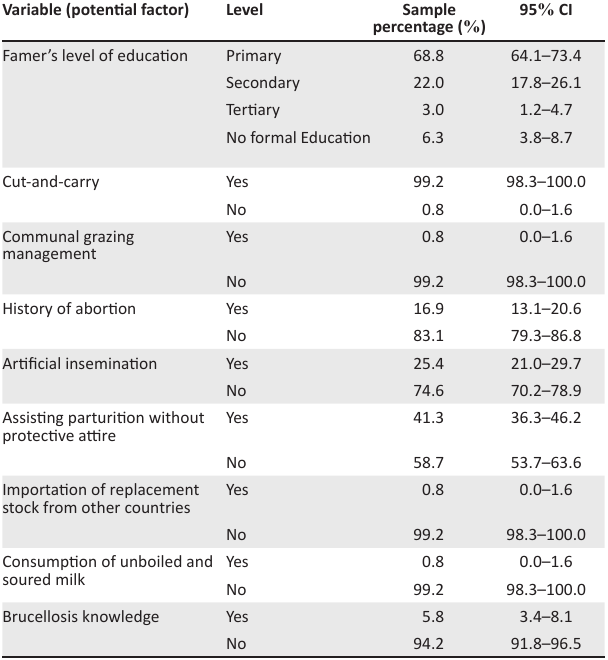
TABLE 2: Potential risk factors and practices of brucellosis in study